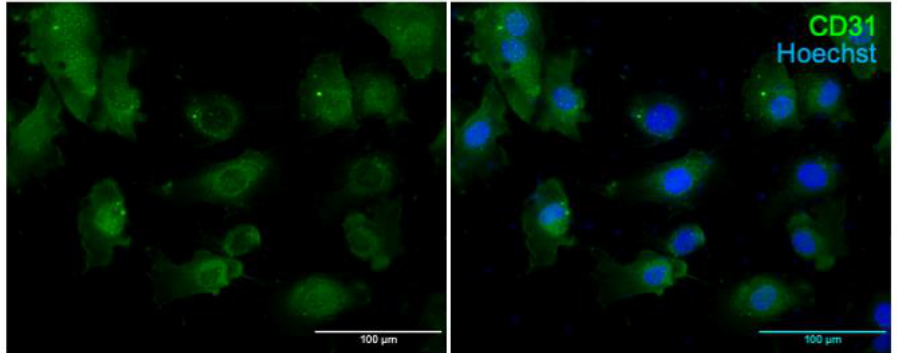
Figure 1. Homogeneity of ECs from brain of neonatal SHRSP. Representative images of immunofluorescence of the isolated cerebral ECs from SHRSP after incubation with CD31 antibody. Alexa Fluor 488 (green) was used as a secondary fluorescent antibody. Cell nuclei were stained with Höechst.